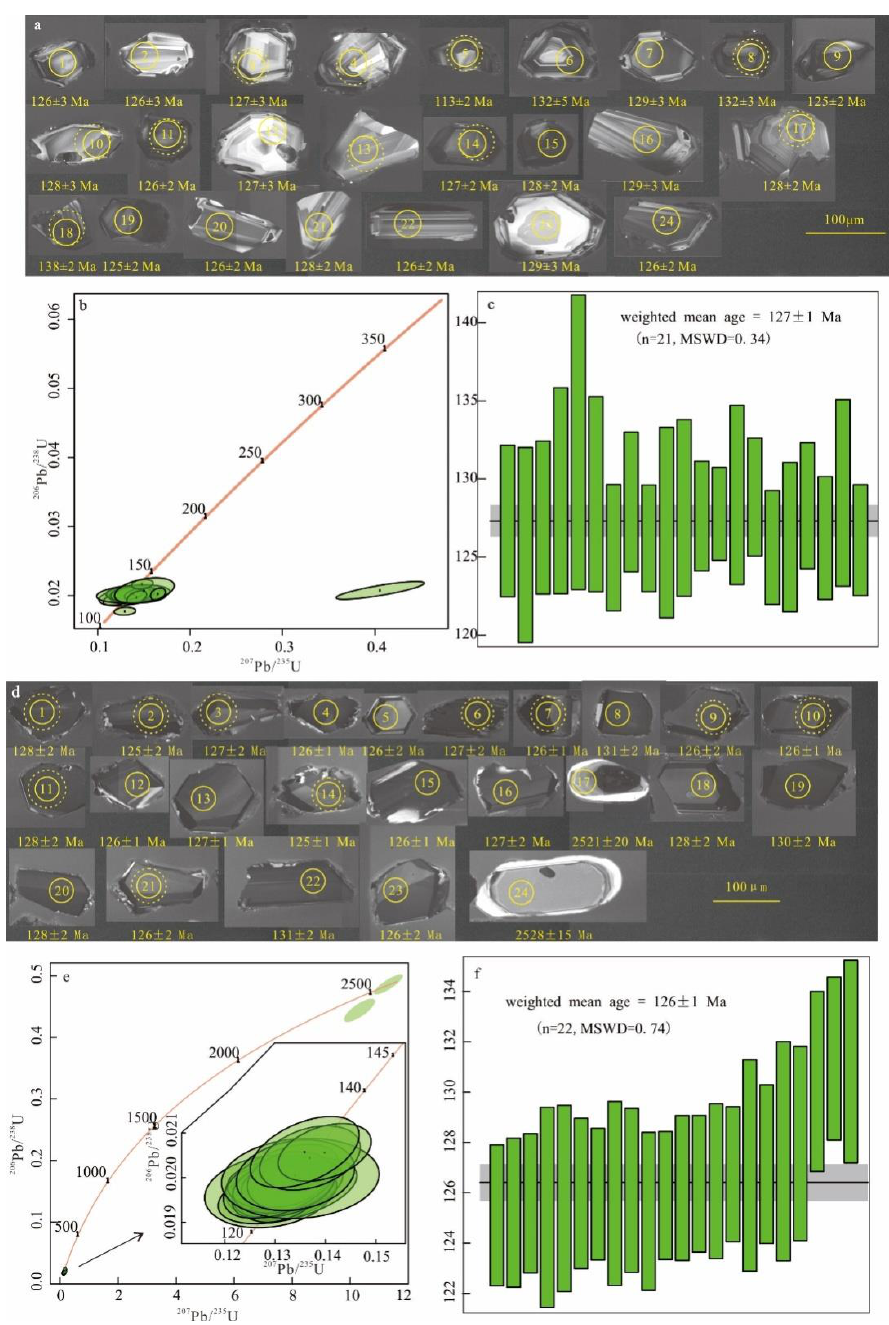
Figure 3. CL pictures ( a , d ), U-Pb Concorde diagrams ( b , e ), and zircon U-Pb weighted mean age ( c , f ) of zircons of quartz monzonites (( a – c )–HS4, ( d – f )–HTS3) from the Jinling area, western Shandong province.